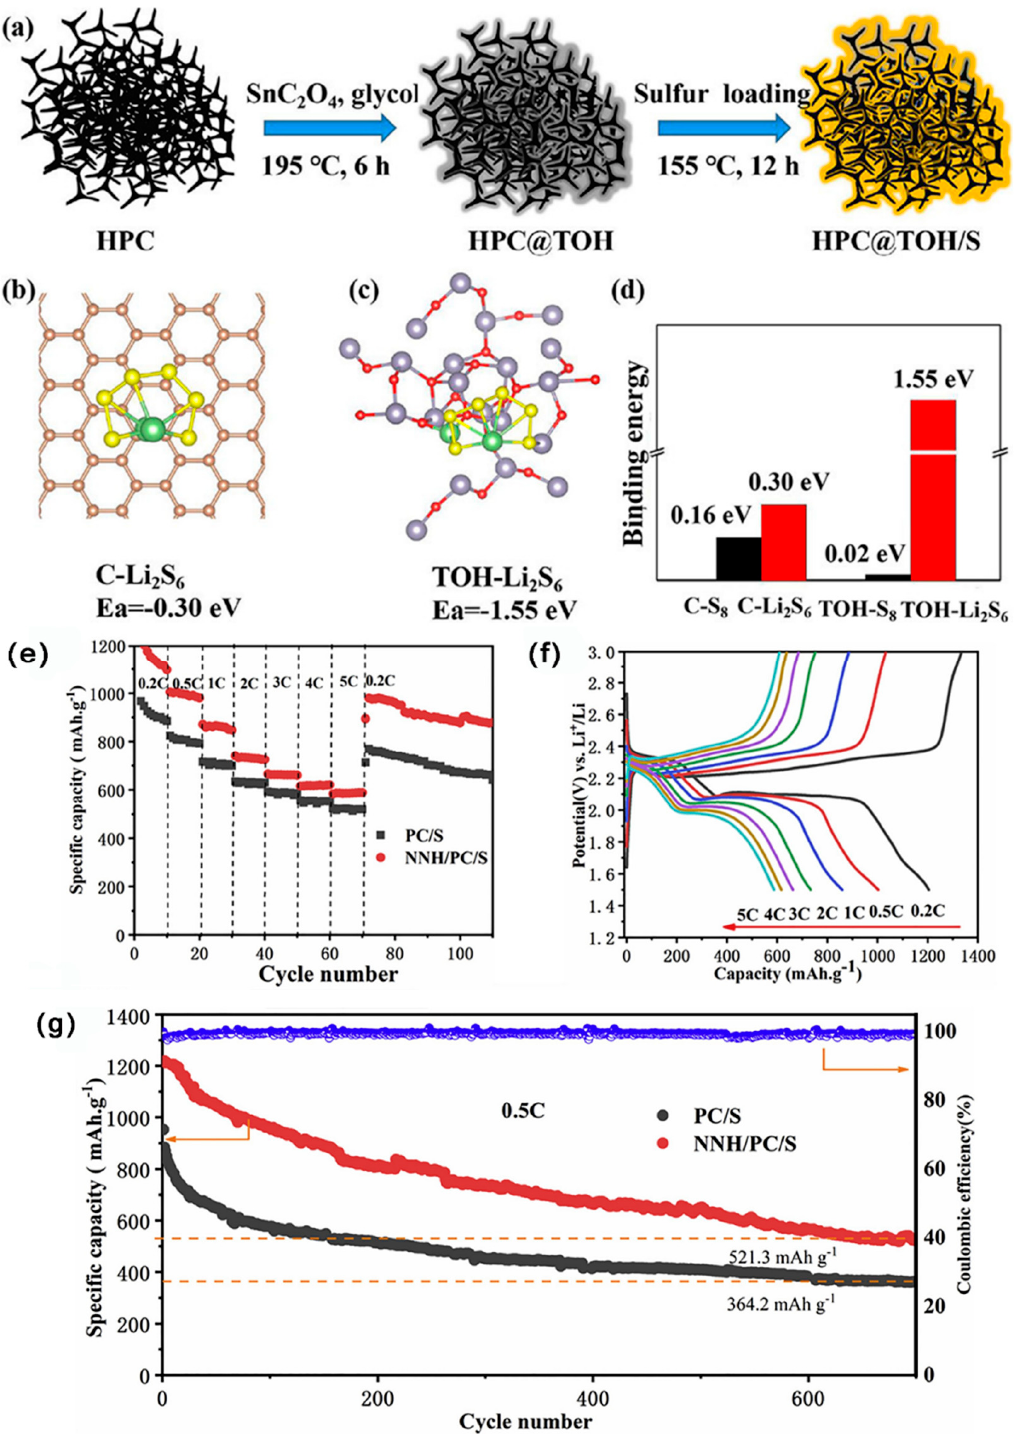
Figure 14. ( a ) Schematic diagram of the preparation of HPC@TOH/S, density functional theory calculations of the adsorption energy for Li 2 S 6 . Optimized atomic structures of ( b ) CLi 2 S 6 , ( c ) TOH- Li 2 S 6 , ( d ) comparison of the binding energies of Li 2 S 6 /S 8 to C or TOH [104]. ( e ) Rate capability of LSBs with NNH/PC/S cathodes. ( f ) NNH/PC/S’ galvanostatic charge and discharge curves with varying current rates between 0.2 C and 5 C. ( g ) Long-term cycling performance of LSBs with NNH/PC/S cathodes at 0.5 C [105].